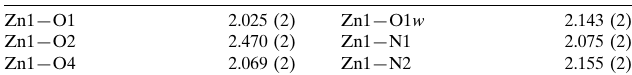
Selected bond lengths (A˚ ).